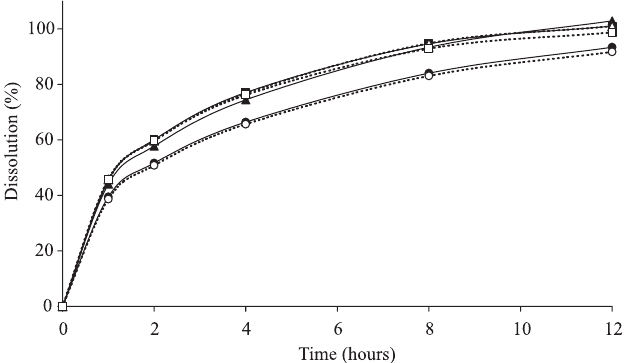
FIGURE 1 - Dissolution profiles for generic 10 mg (  ), generic 20 mg (  ), generic 40 mg (  ), reference 10 mg (  ), reference 20 mg (  ) and reference 40 mg (  )